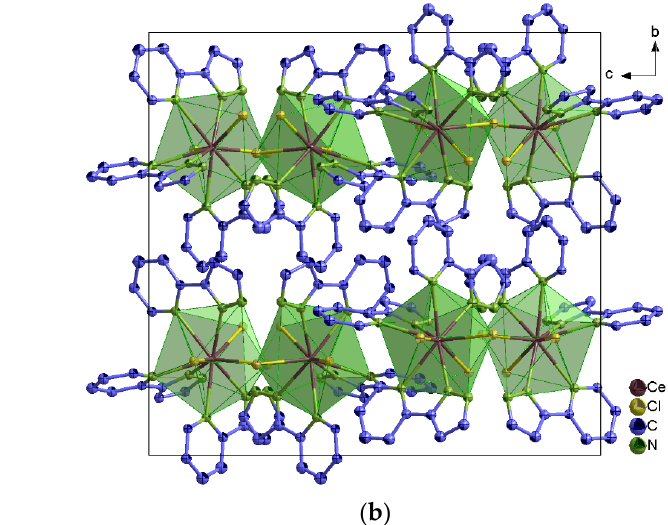
Figure 3. ( a ) Extended coordination sphere of the Ce 3+ ion in [Ce(2–PyPzH) 3 Cl 3 ] ( 11 ).; ( b ) crystal structure of 11 with a view along [100].